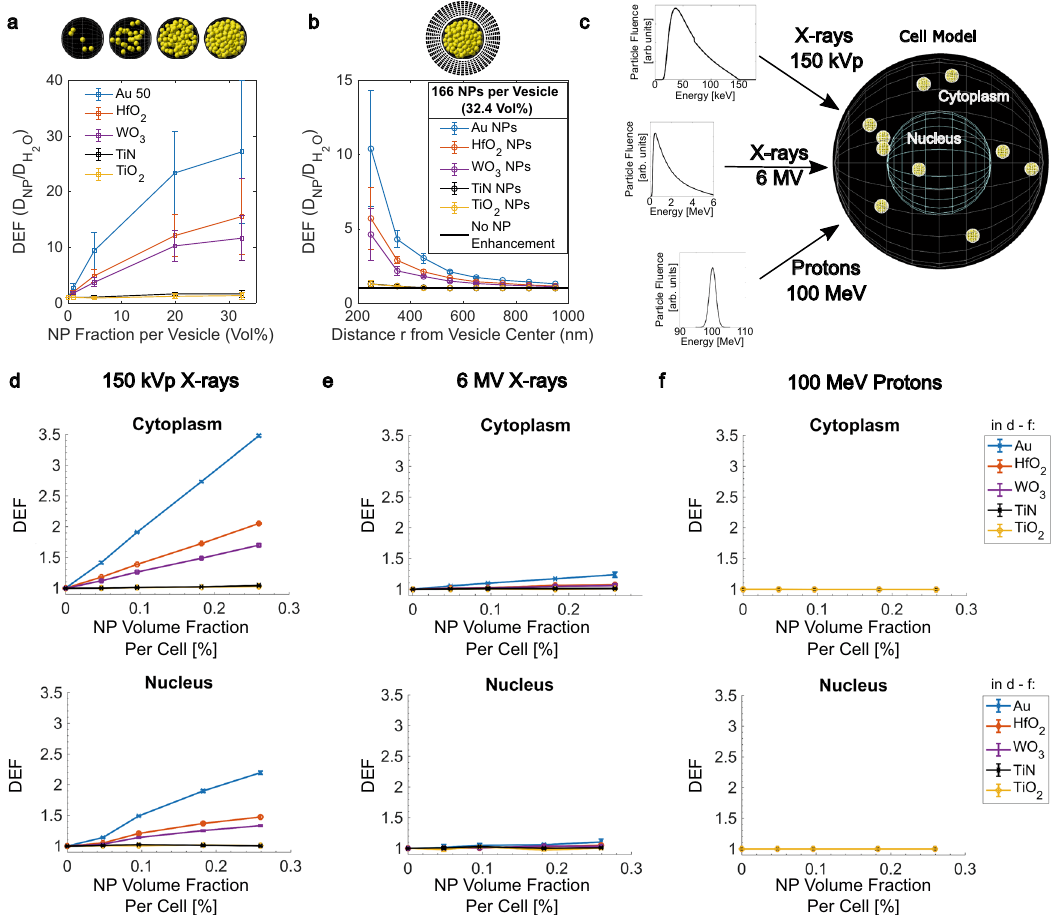
Fig. 3 Physical dose enhancement factors (DEFs) for 50-nm-sized TiO 2 , WO 3 , HfO 2 and Au nanoparticles assessed using Monte Carlo simulations. DEF inside a 400 nm water vesicle fi lled with different amounts of nanoparticles upon irradiation with 150 kVp X-rays ( a ). DEF in 100 nm shells around a 400 nm-sized nanoparticle fi lled with 166 ( = 32.4 vol%) nanoparticles upon irradiation with 150 kVp X-rays ( b ). Schematic illustration of the cell model consisting of a central nucleus and nanoparticle- fi lled vesicles inside the cytoplasm (no nanoparticles in the nucleus) and the particle in fl uence for the different photon and proton beam sources used ( c ). DEF in the cytoplasm and nucleus for 150 kVp X-rays ( d ), 6 MV X-rays ( e ) and 100 MeV protons ( f ). Data in a , b and d – f given as mean ± SD from n = 3 simulation experiments. Source Data are provided as a Source Data fi